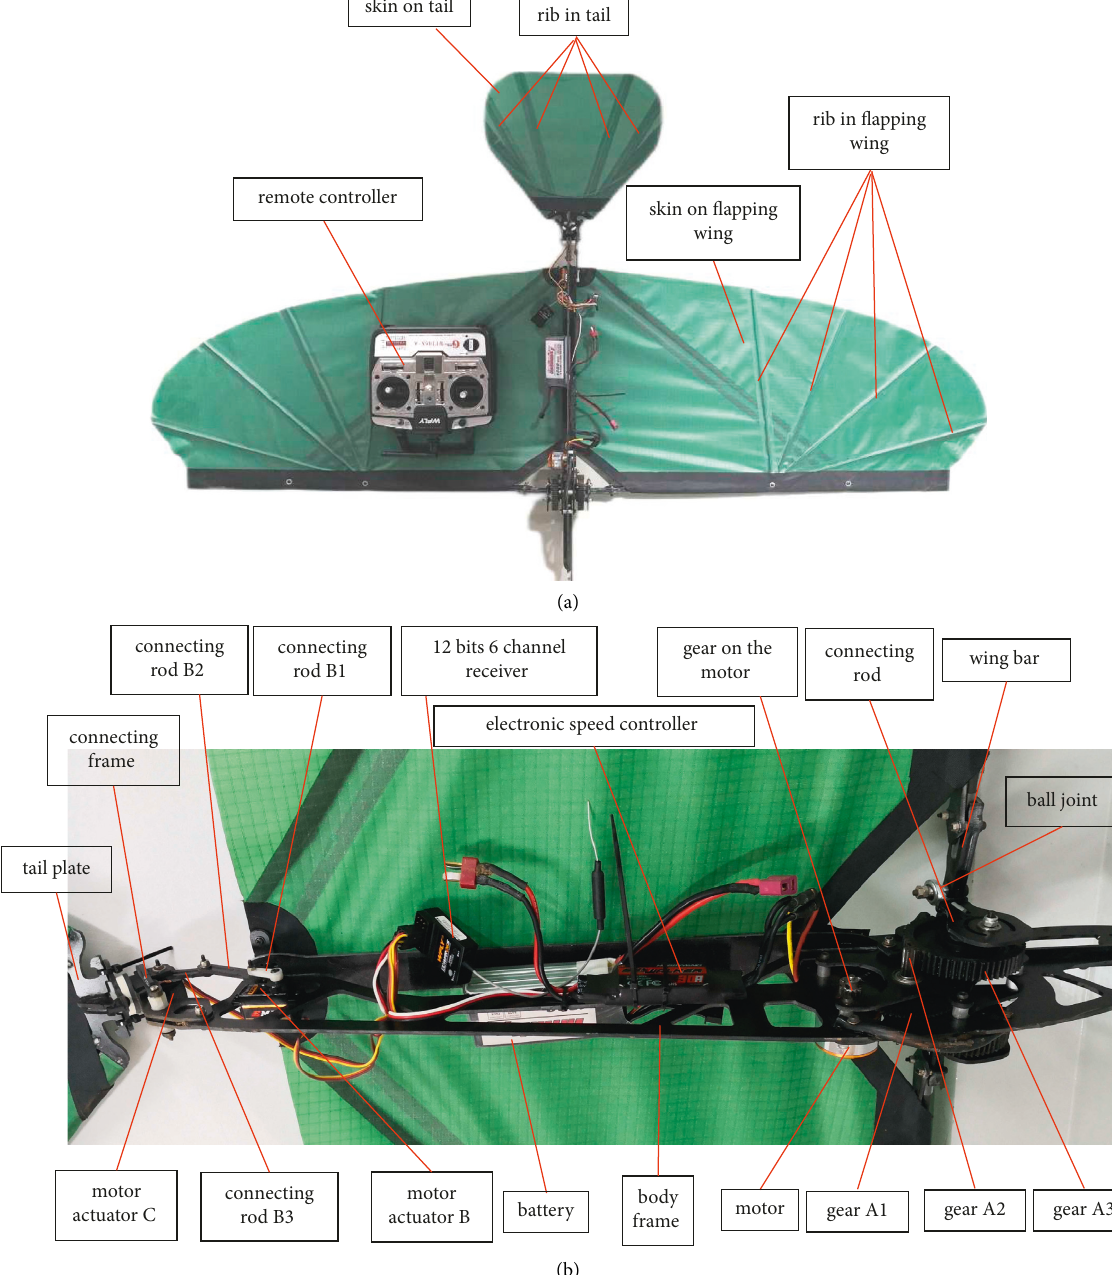
Figure 3: The components of the flapping wing robot. where (a): the robot in global view; (b): the robot in bottom